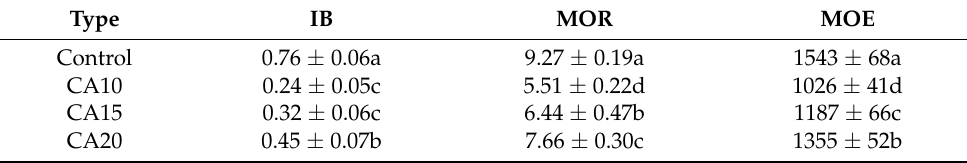
Table 2. Internal bonding (IB), modulus of rupture (MOR) and modulus of elasticity (MOE) of particleboard bonded with UF and different citric acid